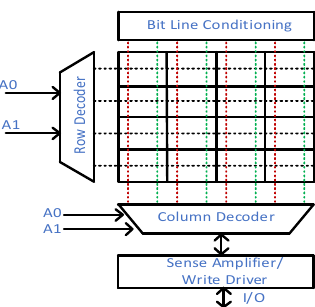
Figure 3. Conventional 6T-SRAM cell with: pull up (PU), pull down (PD) and pass gate (PG) transistors.